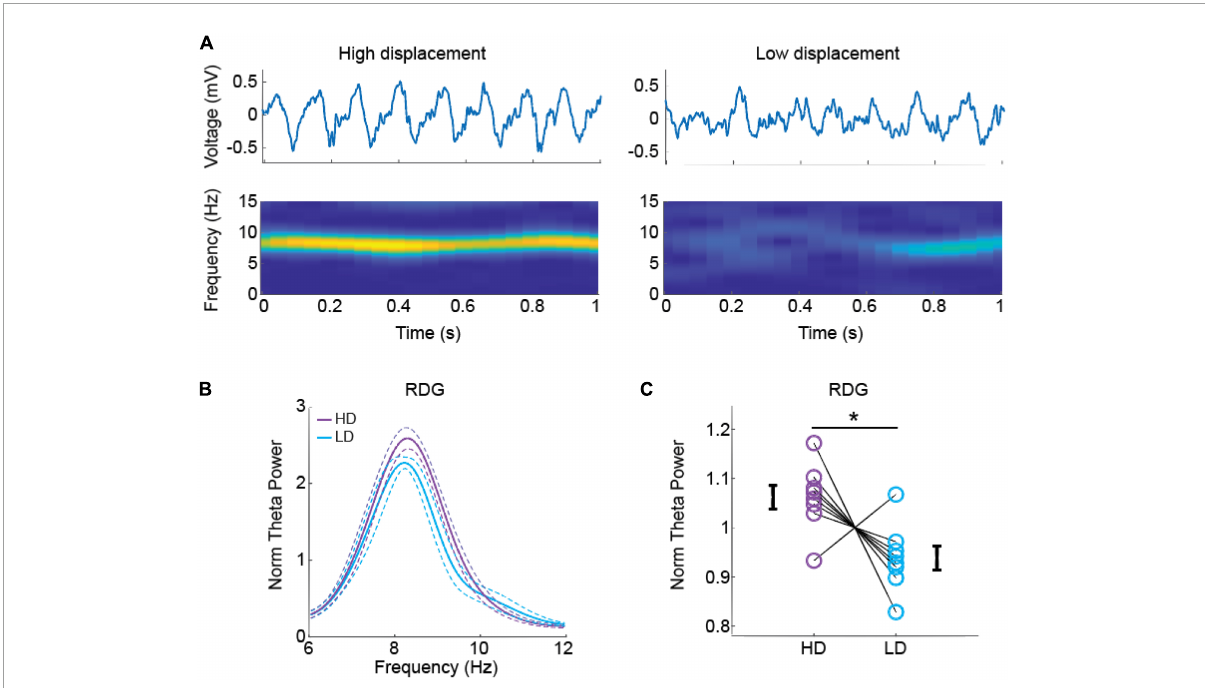
FIGURE3 Theta oscillations in the dentate gyrus (DG) during object exploration in the high and low spatial displacement tests. (A) Representative raw local field potentials (LFP) (upper) and spectrograms (lower) from the right DG during 1-s of object exploration in the high and low spatial displacement tests. (B) Normalized average power spectra at the theta (6–12 Hz) band in the right DG during high and low spatial displacement tests (purple and cyan, respectively). Solid lines represent mean and dashed lines represent SEM. (C) Normalized mean theta power in right DG area at high and low spatial displacement tests. Purple and cyan circles represent normalized theta power from individual rats and error bars represent SEM. Asterisk indicates statistical significance in a paired t test, n = 8 animals.